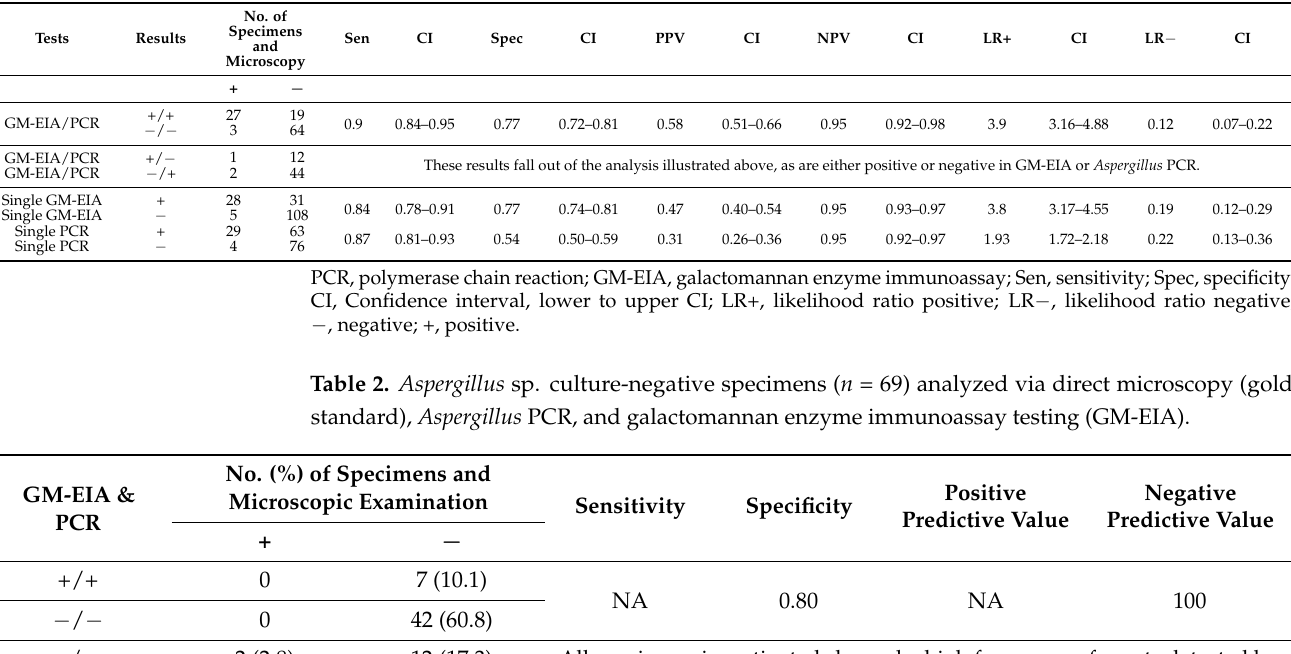
Table 1. Aspergillus sp. culture-positive specimens ( n = 172) analyzed via direct microscopy (gold